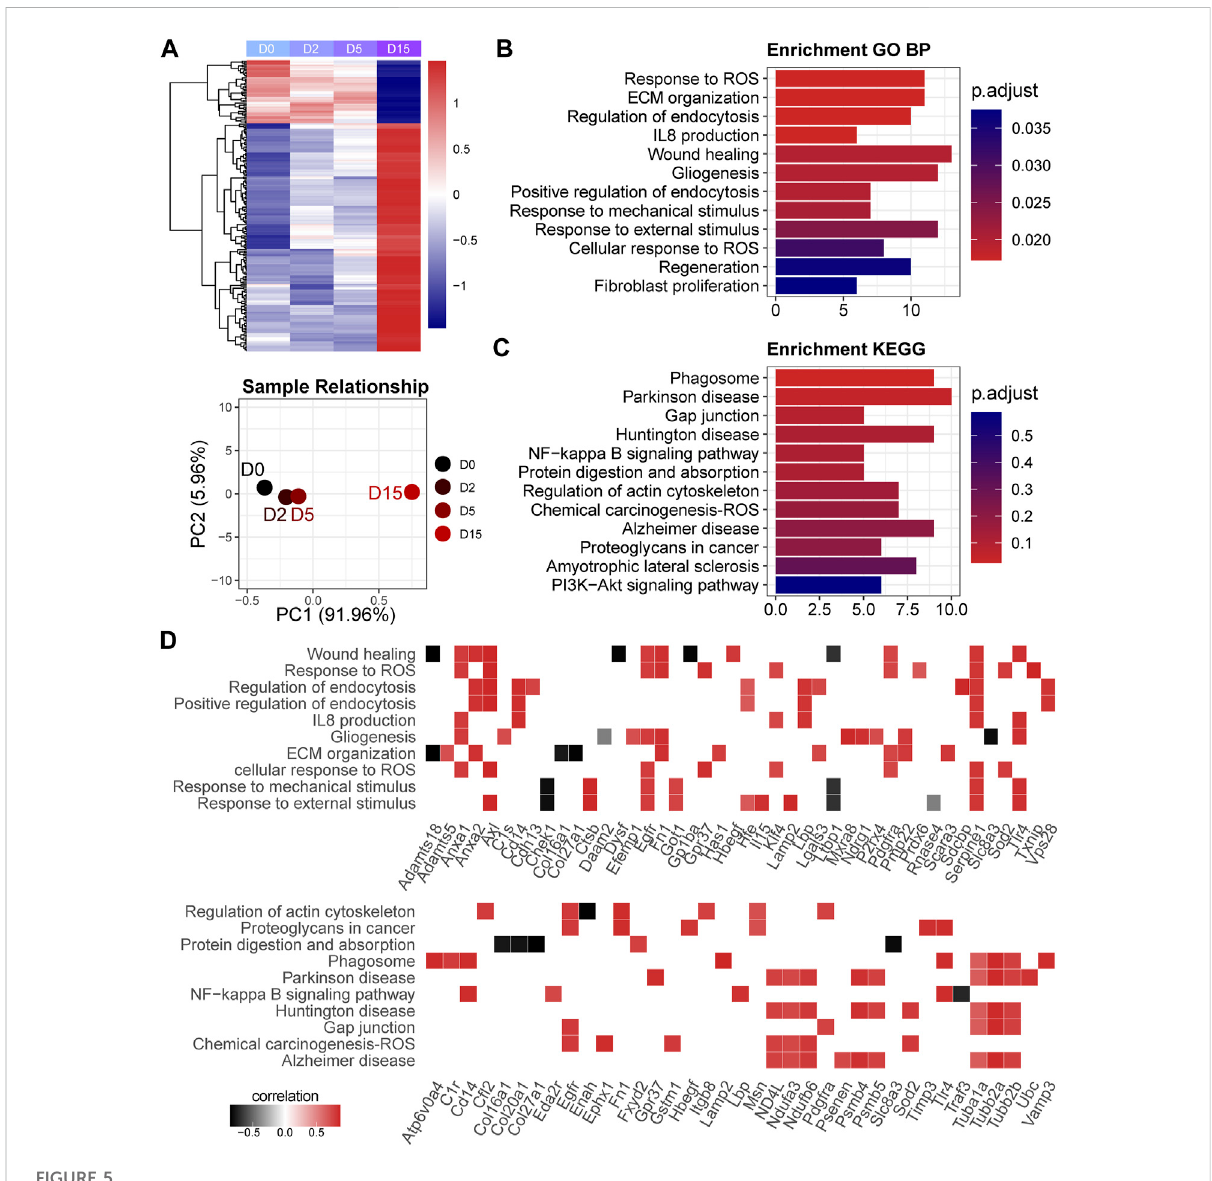
FIGURE 5 Late responsive genes are related to extracellular matrix organization and cellular stress. (A) Heatmap and principal component analysis of late responsive genes ( n = 518). A notable difference exists between D0 and D15. PC1, the fi rst principal component; PC2, the second